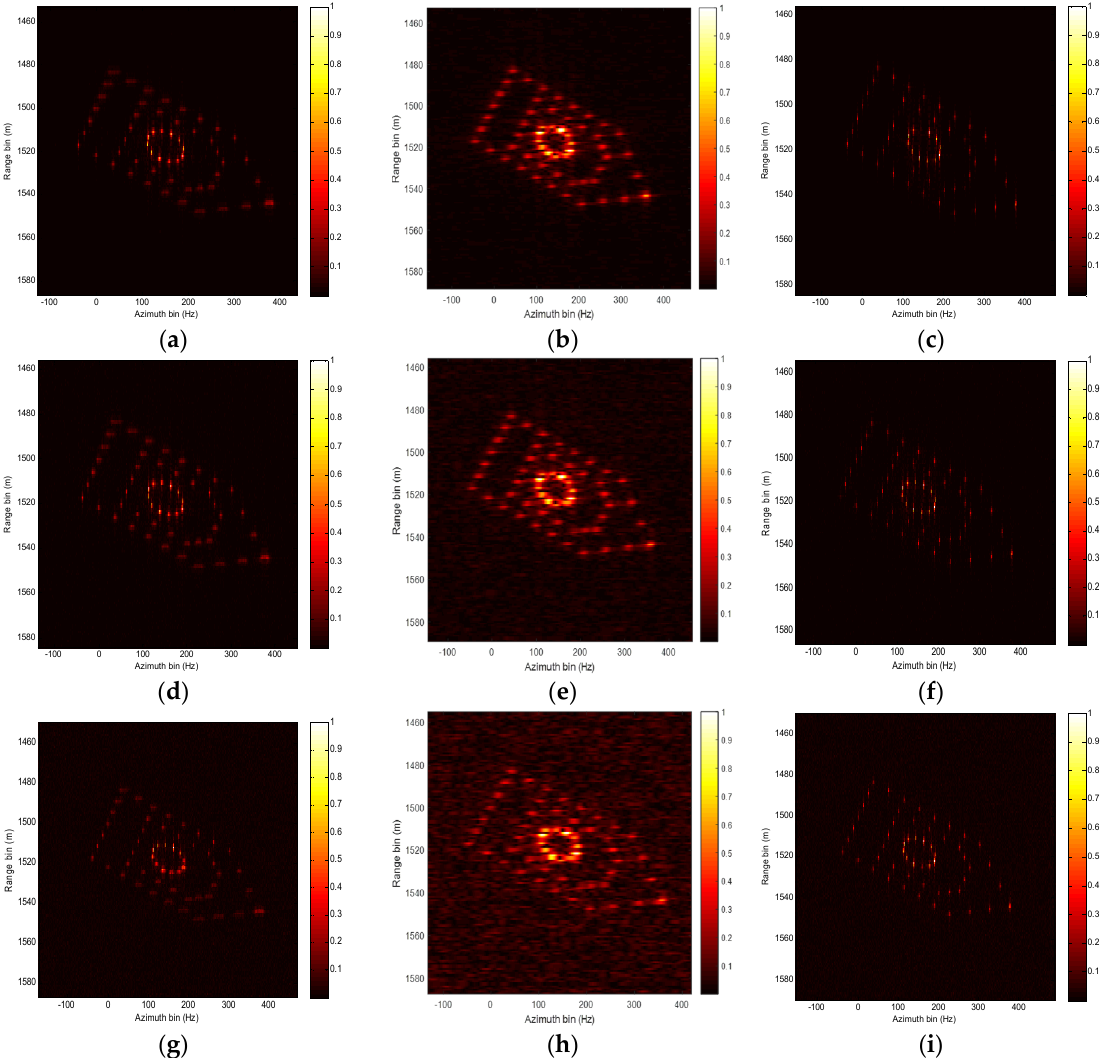
Figure 11. ISAR imaging results with different complex white Gaussian noise. ( a – c ) Imaging results of PGA, STFT, and proposed method under SNR is 0 dB. ( d – f ) Imaging results of PGA, STFT, and proposed method under SNR is − 7 dB. ( g – i ) Imaging results of PGA, STFT, and proposed method under SNR is − 14 dB.